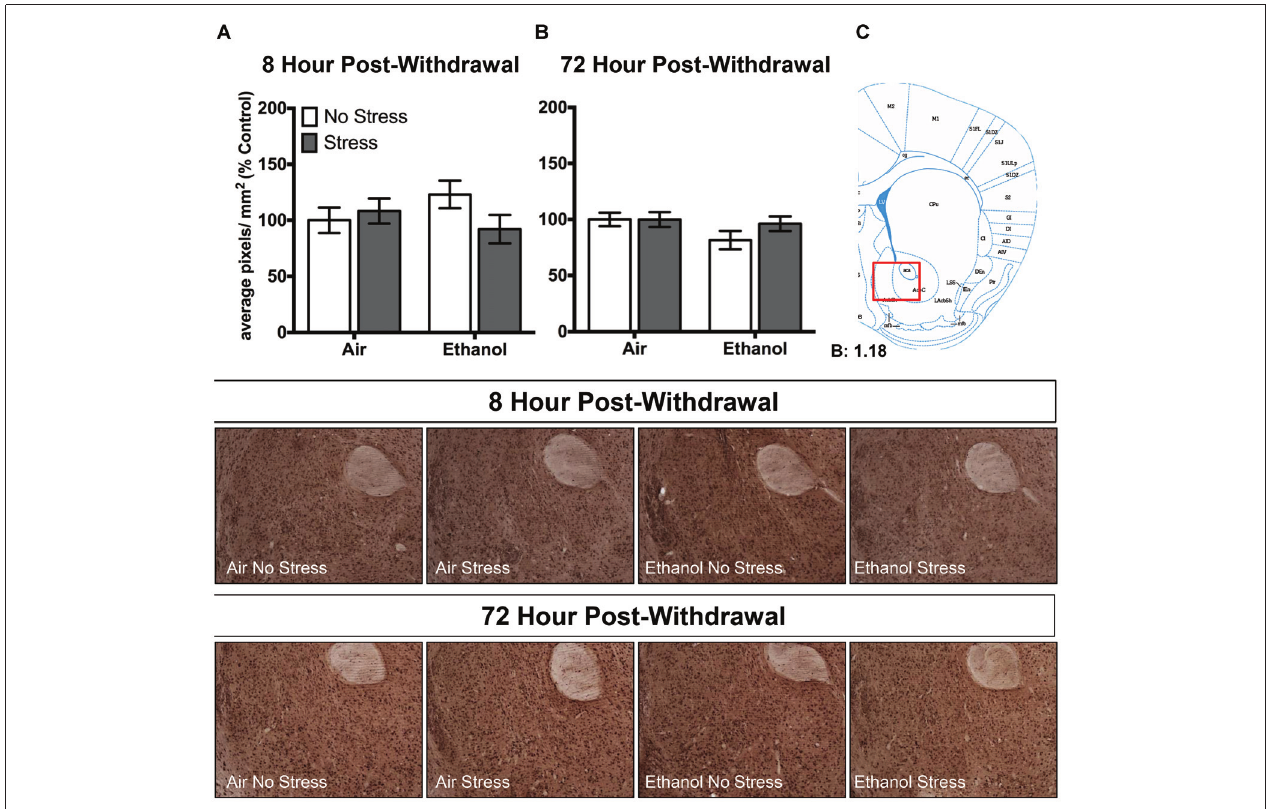
(C) Red box indicates coordinates relative to bregma depicted in photomicrographs. Representative photomicrographs (10x) of 3 α ,5 α -THP immunoreactivity 72 h post-withdrawal following CIE and/or stress